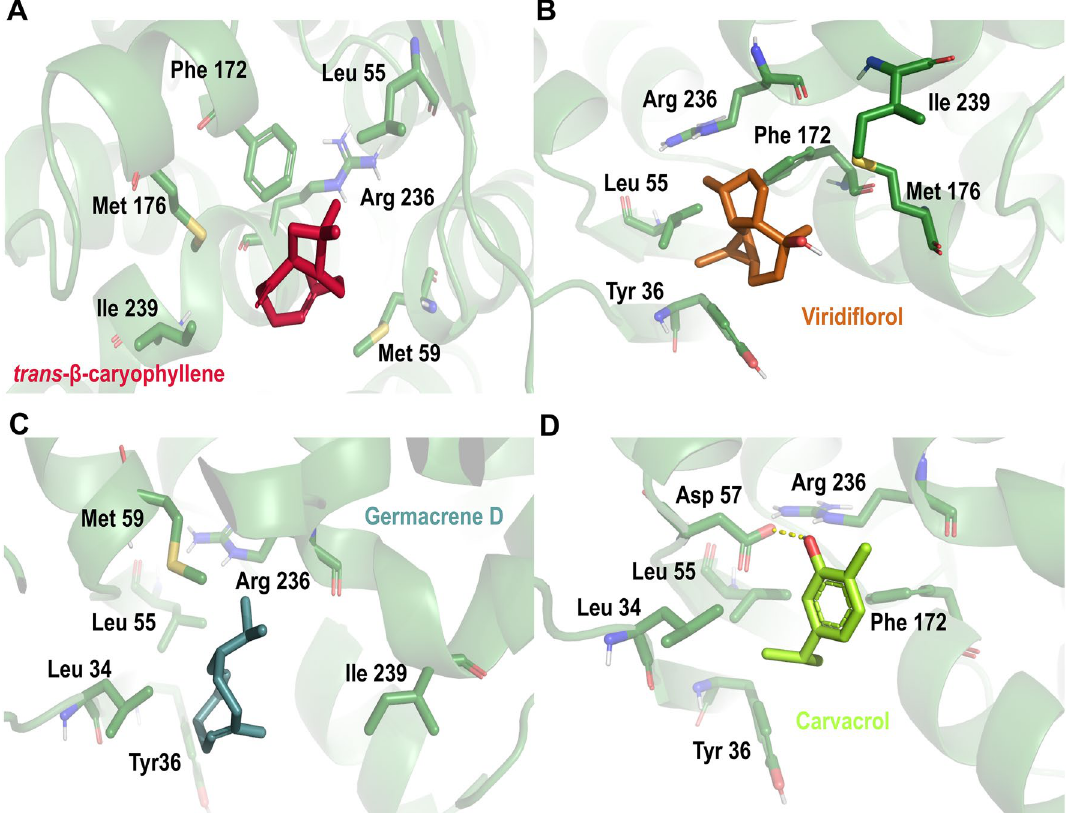
Figure 5. Docking poses of Best ranked secondary metabolites on subunit 5 of mitochondrial complex I in Aedes aegypti . ( A ) trans- ꞵ -caryophyllene; ( B ) viridiflorol; ( C ) Germacrene D; ( D ) carvacrol. Mitochondrial complex I’ residues are colored according to the atom type of the interacting amino-acid residues (protein’s carbon, forest green; oxygen, red; nitrogen, blue). The protein–ligand interactions are represented by dash lines as follows: hydrogen bond interactions are colored in yellow, π-π interactions are colored in